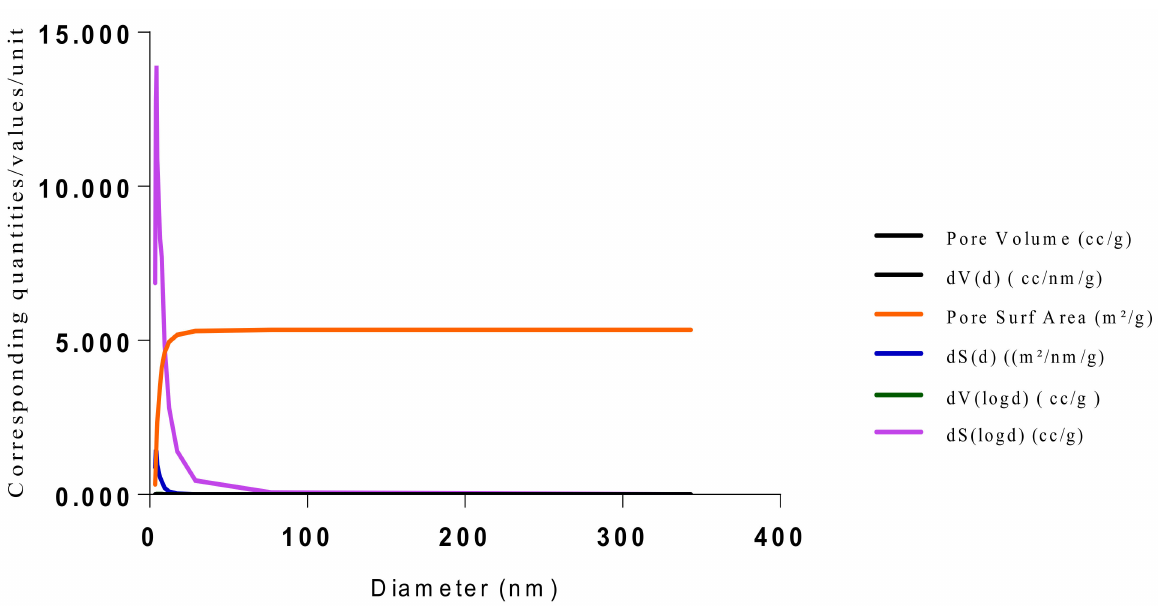
Figure 19. BJH plot for Chitosan-MAA-BAP-3Phenylpridine MIP.